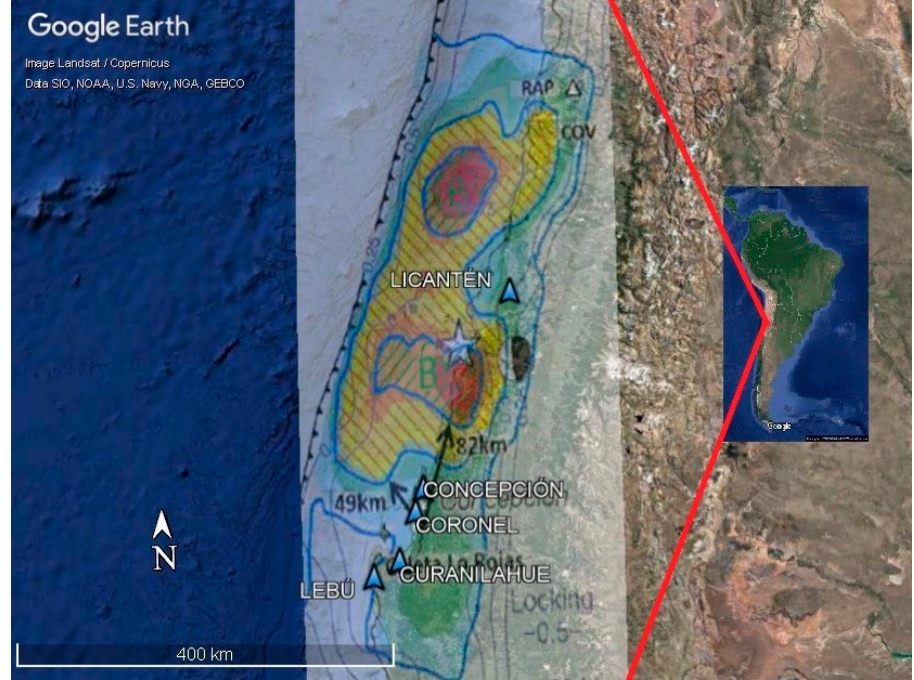
Figure 5. Google Earth ® view of sites with lateral spreading for the 2010 Maule Mw 8.8 Earthquake using Moreno et al.’s (2010) [23] coseismal slip distribution model.